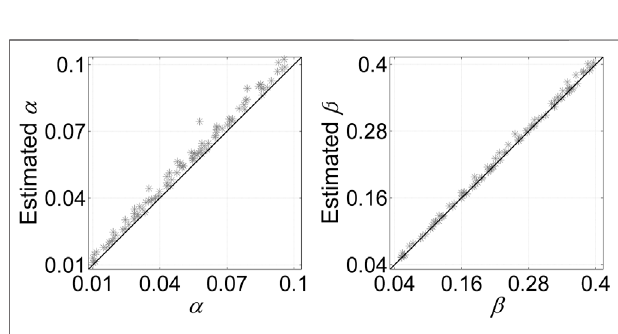
FIGURE 7 | Error rate estimation results of SCClone on the simulated dataset D7. The simulated FPR α changes from 0.01 to 0.1, and FNR β changes from 0.05 to